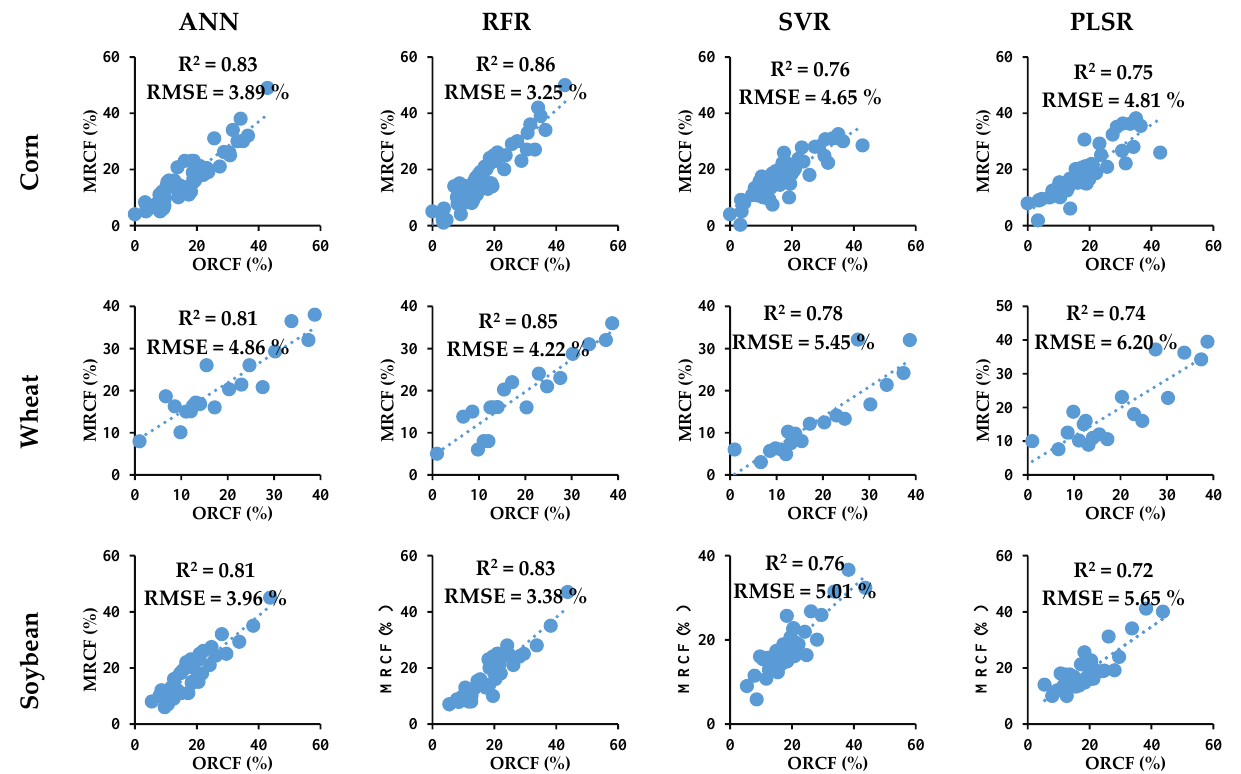
Figure 4. R 2 and RMSE between actual and model RCF based on validation data.